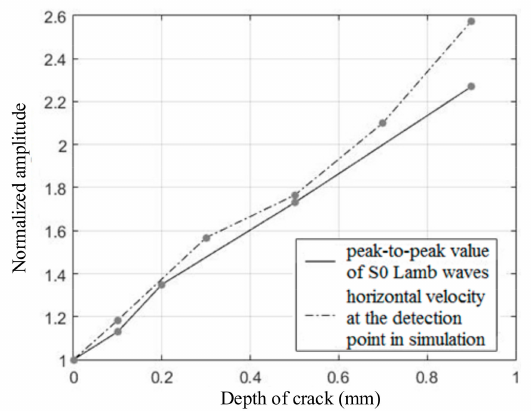
Figure 10. The influence of depth on the near-field enhancement coe ffi cient of S0 Lamb